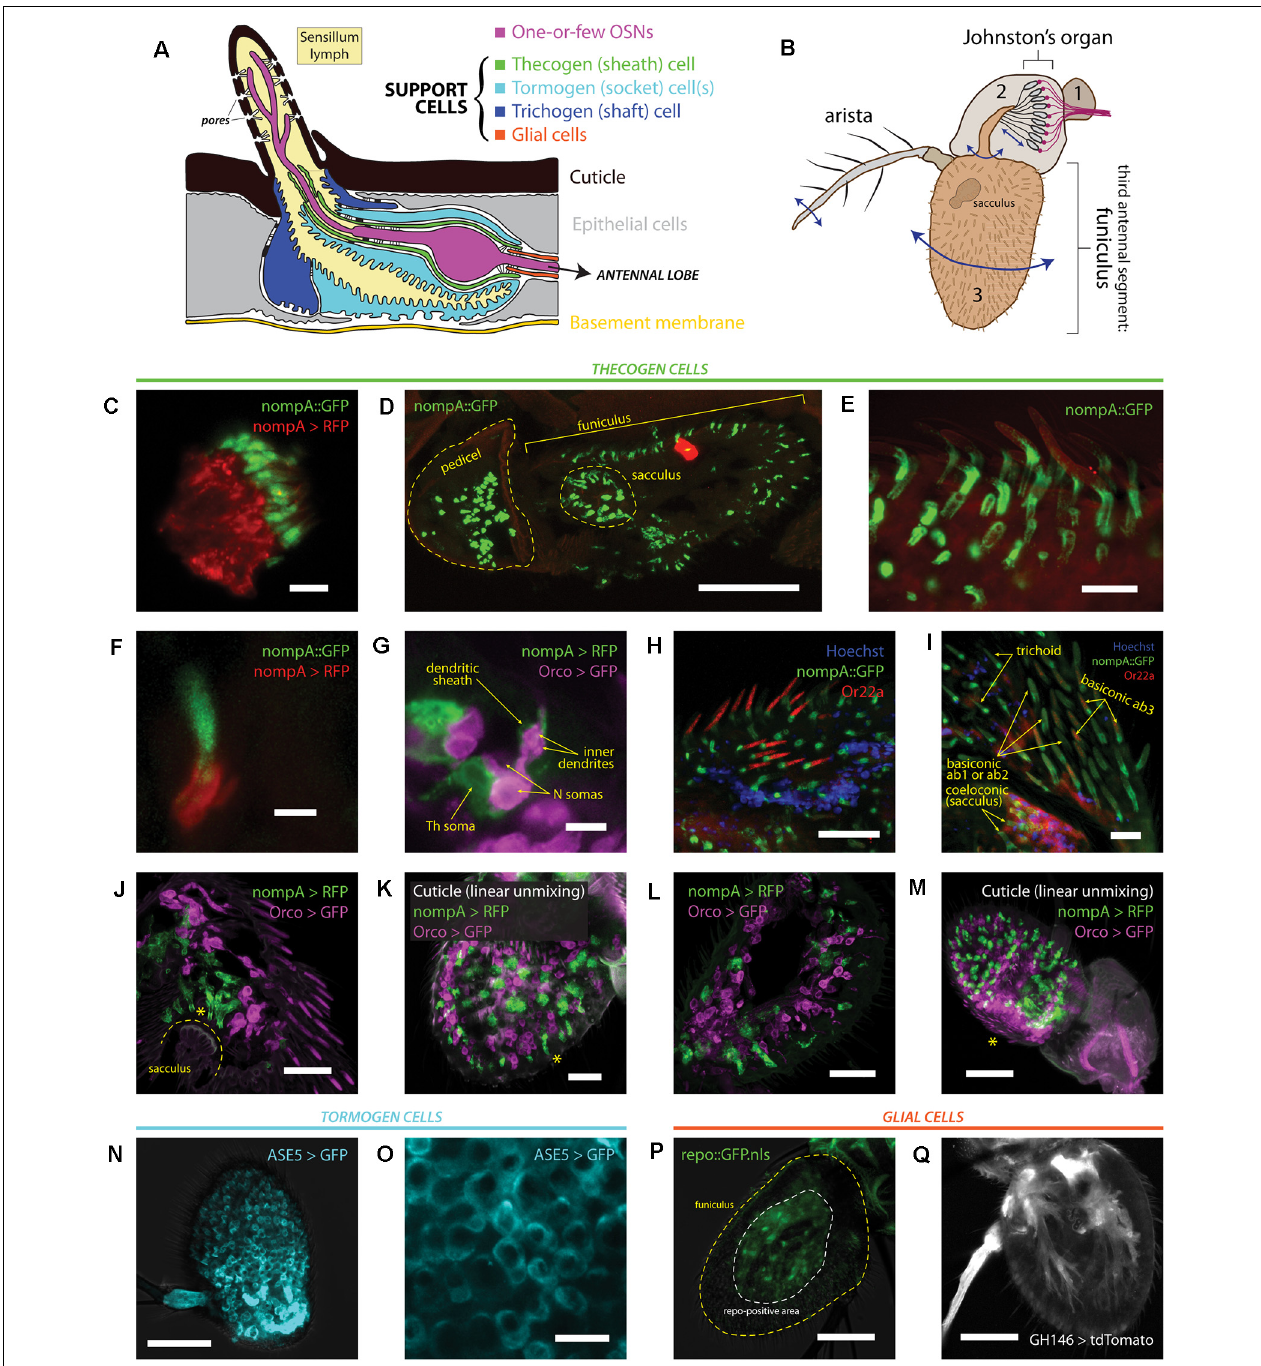
FIGURE 1 | Heterogeneity of antennal cells: patterns of expression of various support cell markers and cell type-specific drivers. (A) Diagram of a typical insect olfactory sensillum and its constituent structures and cells. (B) Illustration of an entire Drosophila antenna. Antennal segments are numbered. Vibrational/rotational movements of arista and segment 3 (funiculus) are transduced by the Johnston’s organ in segment 2 (pedicel), while segment 3 and its characteristic pit (sacculus) harbor the vast majority of chemosensory sensilla on the antenna. (C) Immunofluorescence of scolopale cells and nompA protein in the Johnston’s organ. Scale bar: 5 µ m. (D) Immunofluorescence micrograph of longitudinally cryosectioned D. melanogaster antenna, showing the presence of nompA protein in both scolopale cells of the pedicel and cells in the funiculus and sacculus. Scale bar: 50 µ m. (E) Maximum intensity projection of confocal imaging of whole antenna using Airyscan. nompA protein forms distinct tube-like, sheathing structures under sensilla. Scale bar: 10 µ m. (F) Immunofluorescence of sectioned antenna showing thecogen cells excreting nompA extracellularly, similarly to scolopale cells in the second antennal segment. Scale bar: 2 µ m. (G) nompA GAL4-driven reporter expression